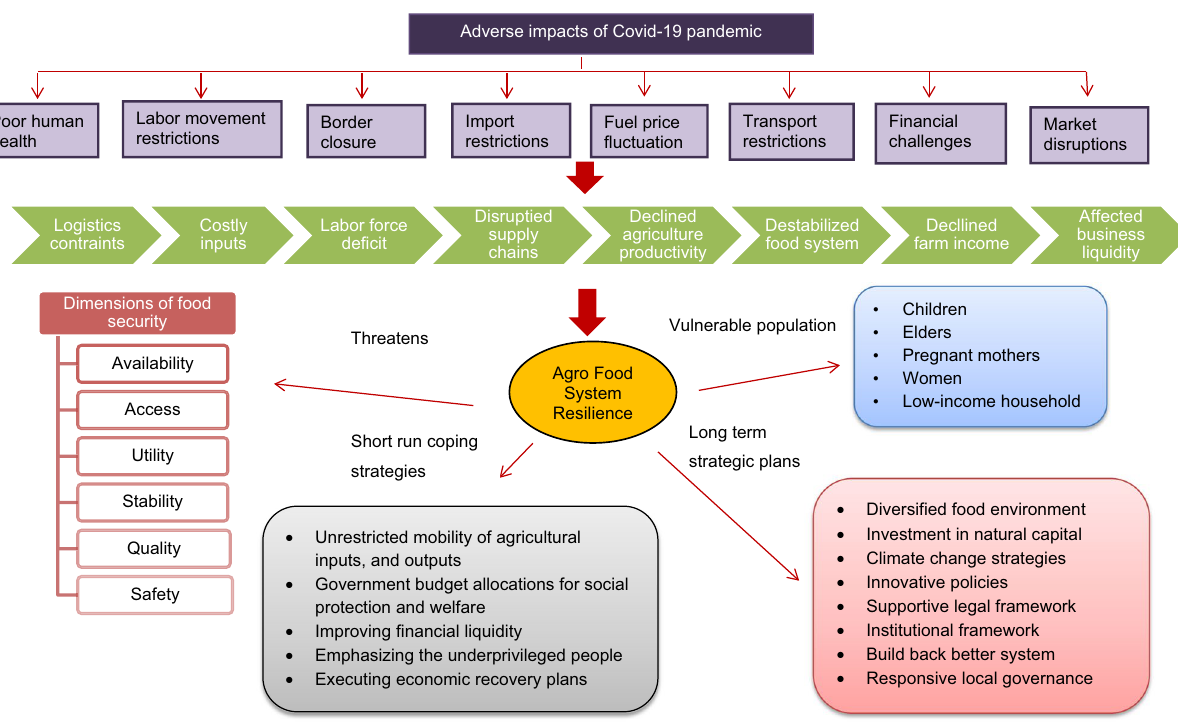
Fig. 4 Impacts of Covid-19 food system dynamics on six dimensions of food security, and coping strategies to tackle the pandemic. Source: [6, 8, 22, 51, 82, 84, 114]